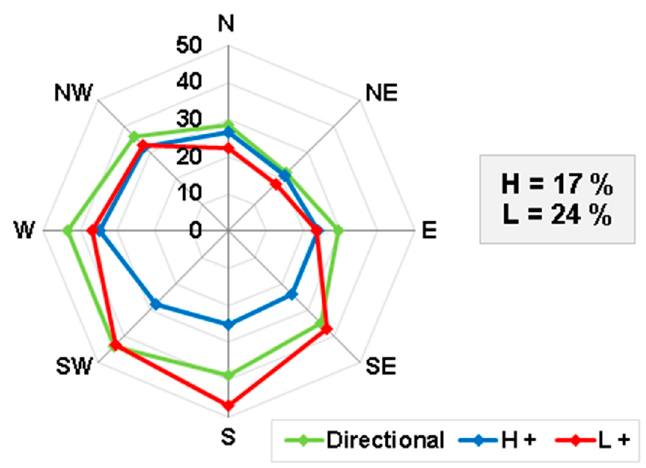
Figure 9. Average daily capacity factor according to the different weather regimes. The pure weather regimes “H” and “L” are also represented.